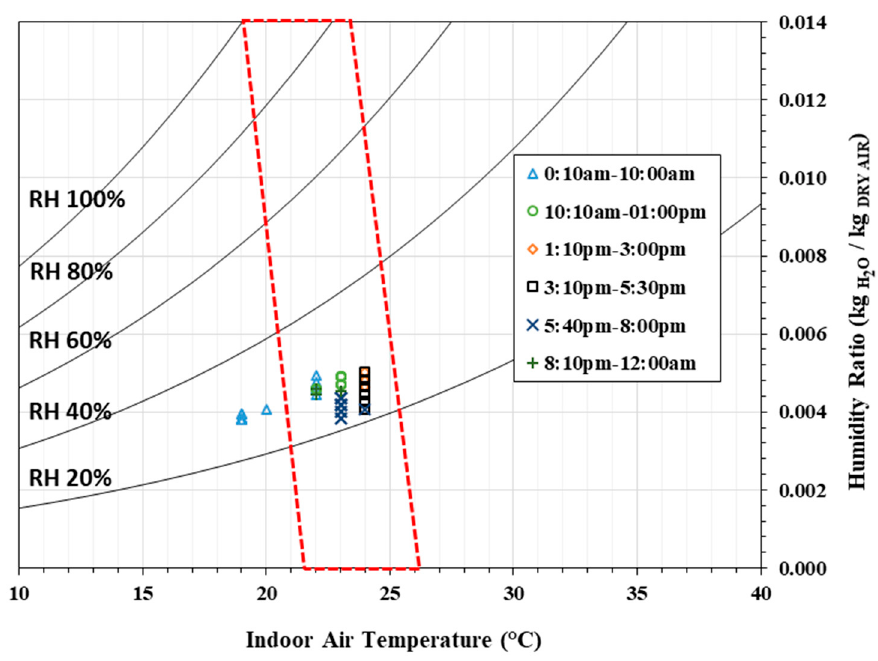
Figure 10. Psychrometric chart and time analysis on the day when the ERV system was on (9 March 2020).